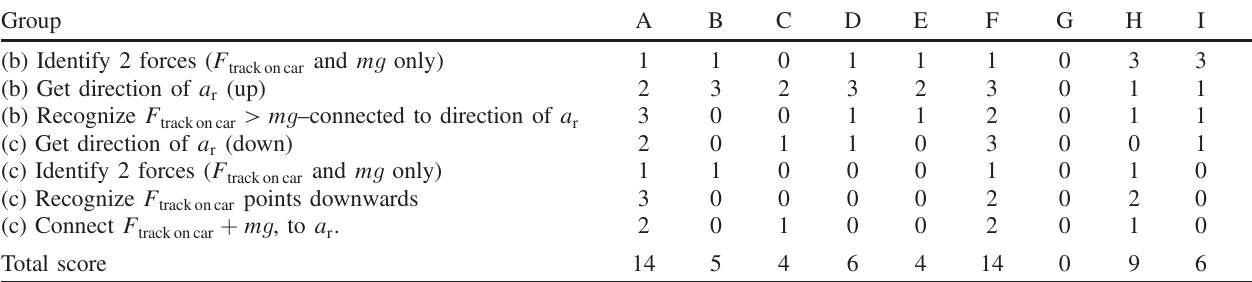
TABLE II. Group effectiveness scores for all 10 groups for the roller coaster activity. Group A